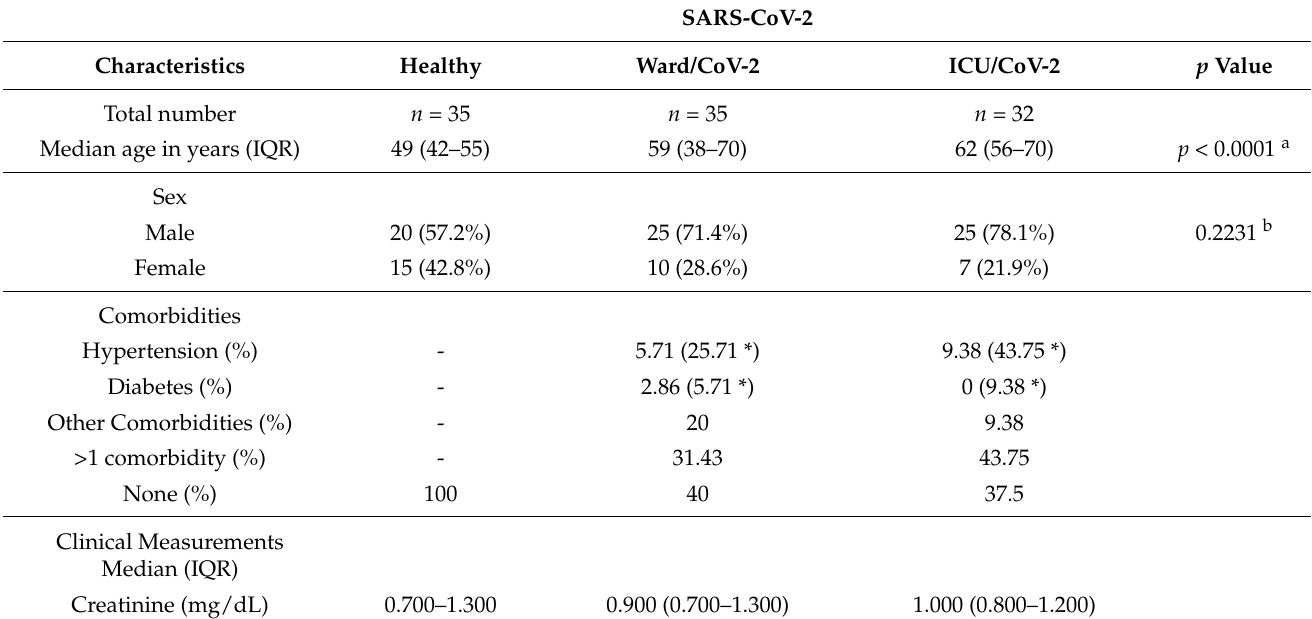
Table 3. Demographic data and in-hospital measured laboratory parameters of subjects whose blood samples were